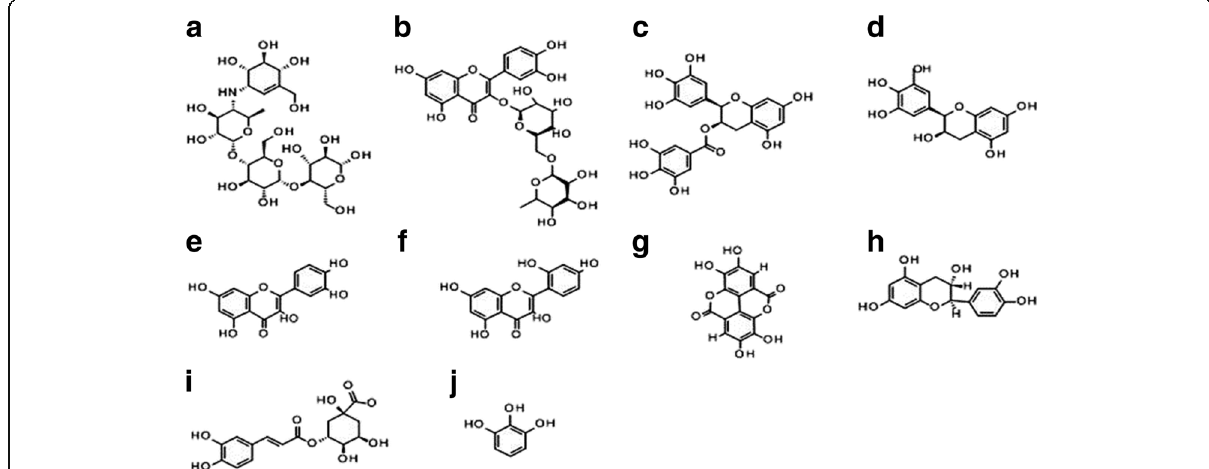
Fig. 1 Phenolic Compounds identified in E. umbellata Thunb. fruit methanolic extract/fractions studied in molecular docking. a Acarbose, b Rutin, c Epigallocatechin gallate, d Epigallocatechin, e Quercetin, f Morin, g Ellagic acid, h Catechin, i Chlorogenic acid, j